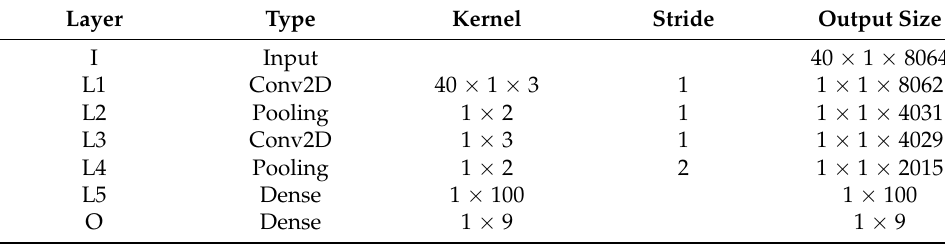
Table 2. Middle-channel network structure diagram.